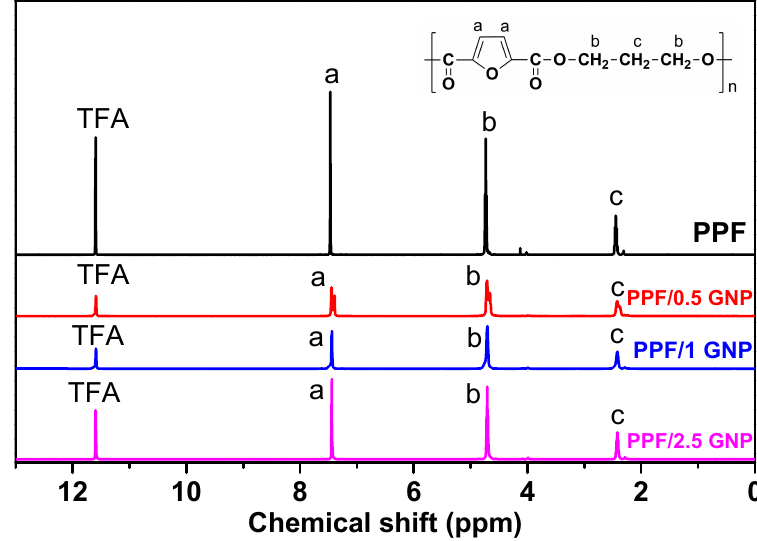
Figure 1. PPF structure, 1 H-NMR spectra and peak assignments of PPF and PPF/GNP nanocomposites.